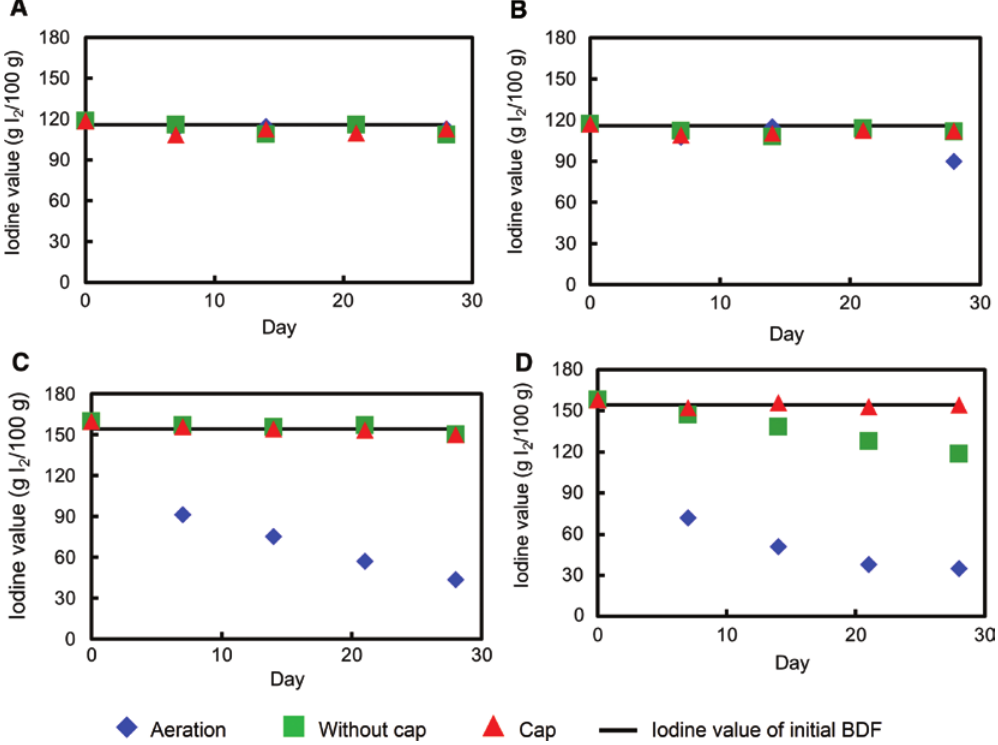
Figure 3: Iodine value of RO BDF and VMO BDF at 30 ° C and 40 ° C under different storage conditions. (A) RO BDF at 30 ° C, (B) RO BDF at 40 ° C, (C) VMO BDF at 30 ° C, (D) VMO BDF at 40 ° C. Blue: the impinger was connected to an air pump for aeration; green: the impinger was opened to the environment and exposed to air; red: the impinger was sealed with a cap; black line: iodine value of initial BDF.